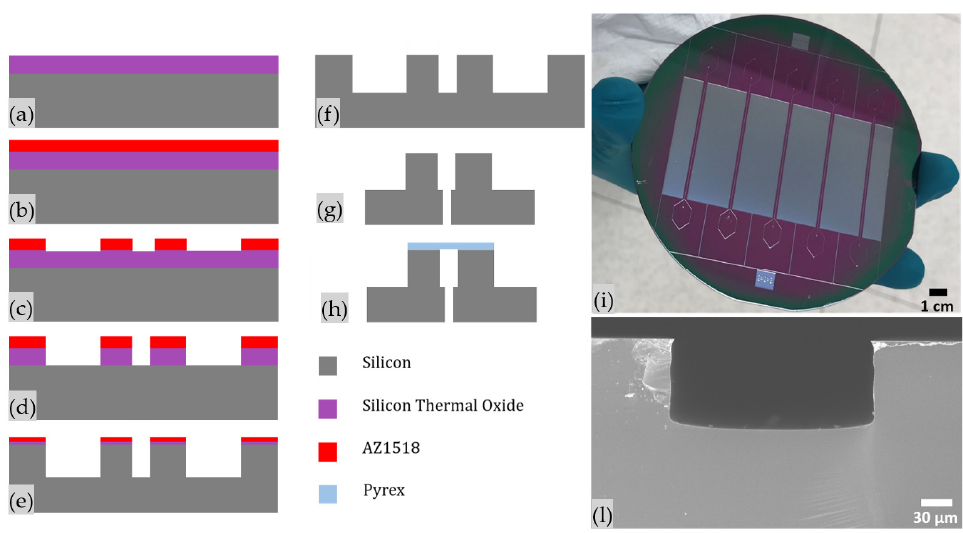
Figure 1. Chip Process Flow: ( a ) starting substrate cleaning, ( b ) photoresist spin coating, ( c ) photoresist exposure and development, ( d ) buffer oxide etching, ( e ) silicon deep reactive ion etching, ( f ) buffer oxide etching, ( g ) inlet/outlet laser drilling and chip dicing, ( h ) anodic bonding, ( i ) BAW devices after DRIE process and ( l ) Field Emission Scanning Electron Microscope (FESEM) cross section image of the separation channel.